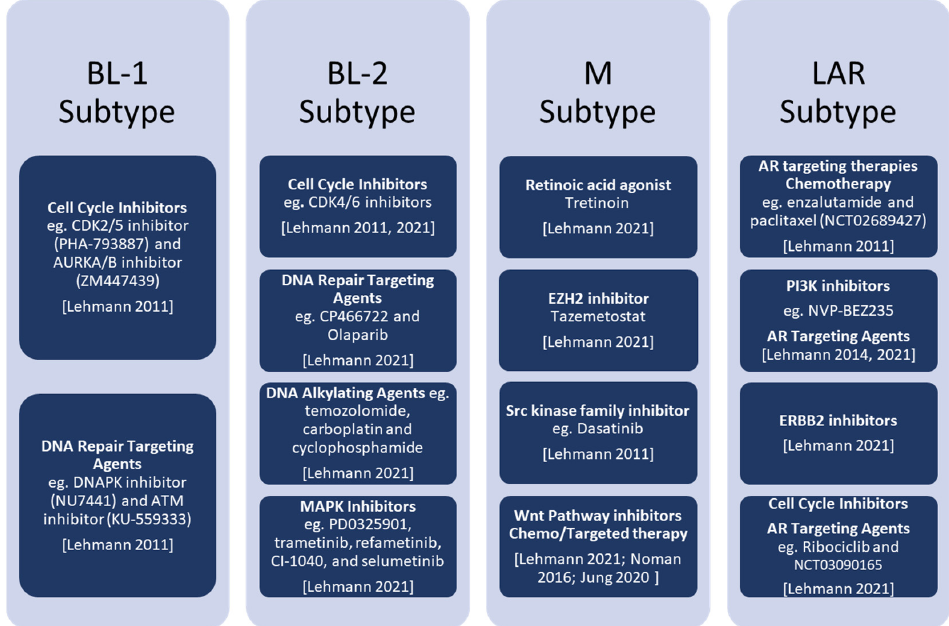
Figure 3. Current therapeutics available for TNBC subtypes